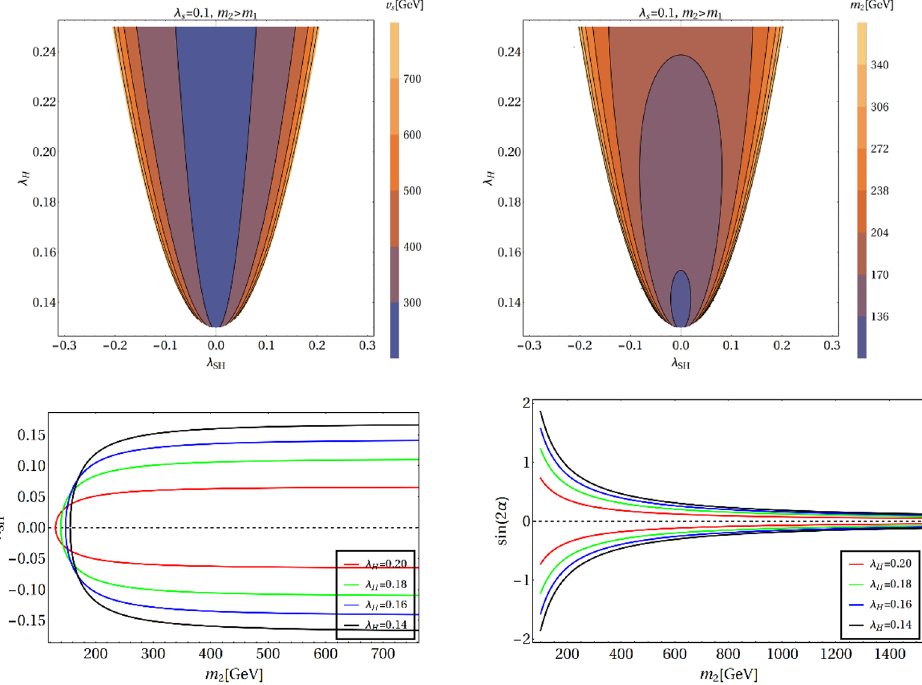
Figure 1 . Top: the contours show allowed range of the vev v S and mass of the decoupled heavy scalar m 2 as a function of λ H and λ SH for fixed λ S = 0 . 1 . Bottom left: λ SH as a functions of m 2 for fixed values of λ H . Bottom right: sin(2 α ) as a functions of m 2 for fixed values of λ H . Decoupling of the dark sector is clearly seen in the limit of large m 2